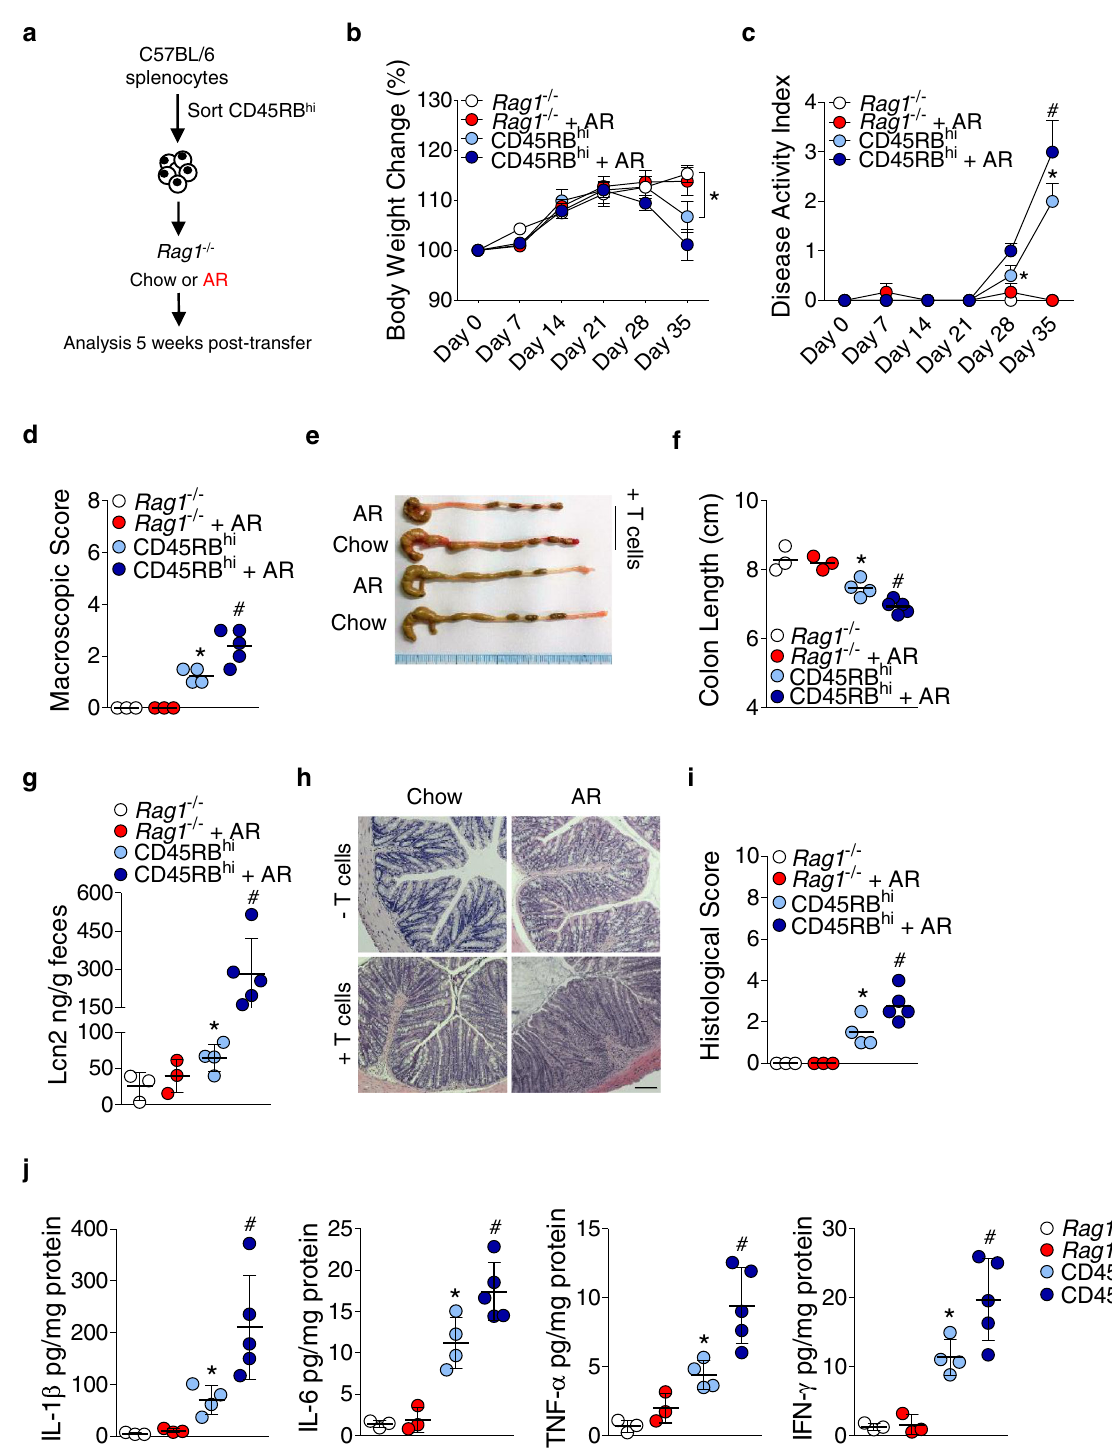
Fig. 2 | AR exposure exacerbates the development of T cell-induced colitis model. a Schematic illustration of the experimental design. Brie fl y, Rag1 − / − mice werereconstitutedwithFACS-sortedCD4 + CD45RB hi Tcellsharvestedfromspleens ofhealthyC57BL/6mice. Rag1 − / − micewereeitherfednormalchowdietorexposed to 100ppm AR via diet at the time of reconstitution. b Body weight change. c Disease activity index (DAI). d Macroscopic score. e A representative image of colons. f Colon length (cm). g Fecal LCN2 levels. h Representative images of hematoxylin and eosin (H&E)-stained colonic sections; scale bar: 100 µ m.